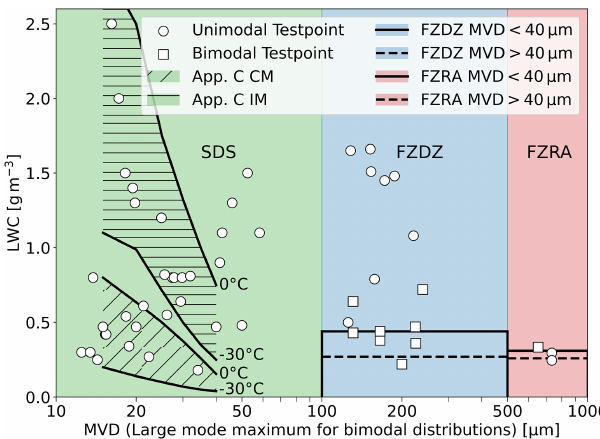
Figure 4. IWT test points used in this study, grouped by droplet spray category. For unimodal test points, the markers represent the MVD, while for bimodal test points the diameter at the maximum of the large droplet mode is shown. We also show the Appendix C en- velopes for continuous maximum icing conditions (CM) and inter- mittent maximum icing conditions (IM) and the Appendix O maxi- mum LWC envelopes from Cober and Isaac (2012) for comparison.